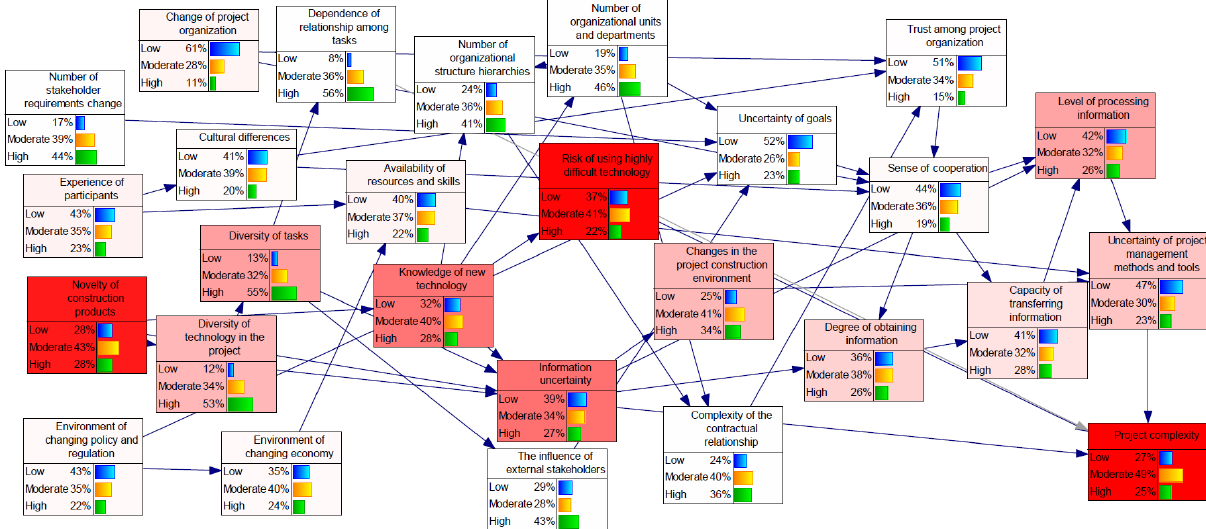
Figure 8. Result of the sensitivity analysis of BBN-based project complexity measurement